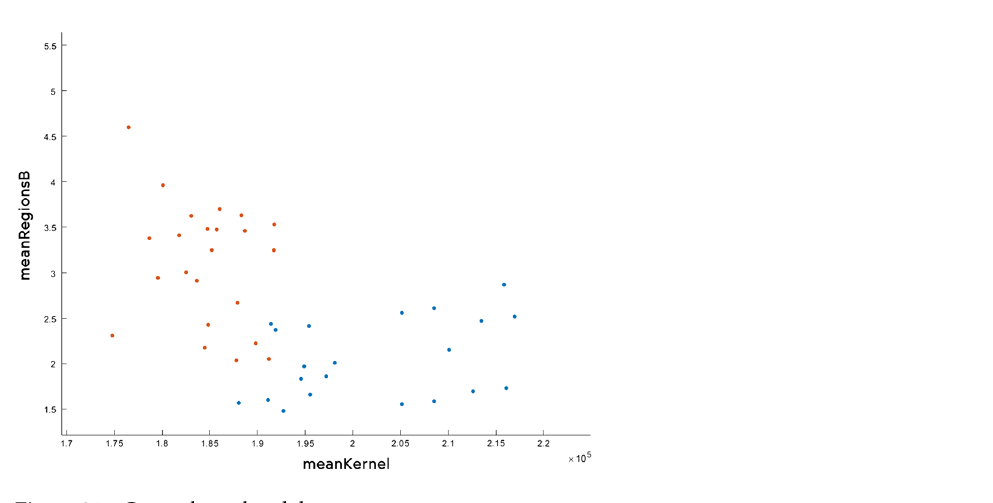
Figure 25. Correctly analysed